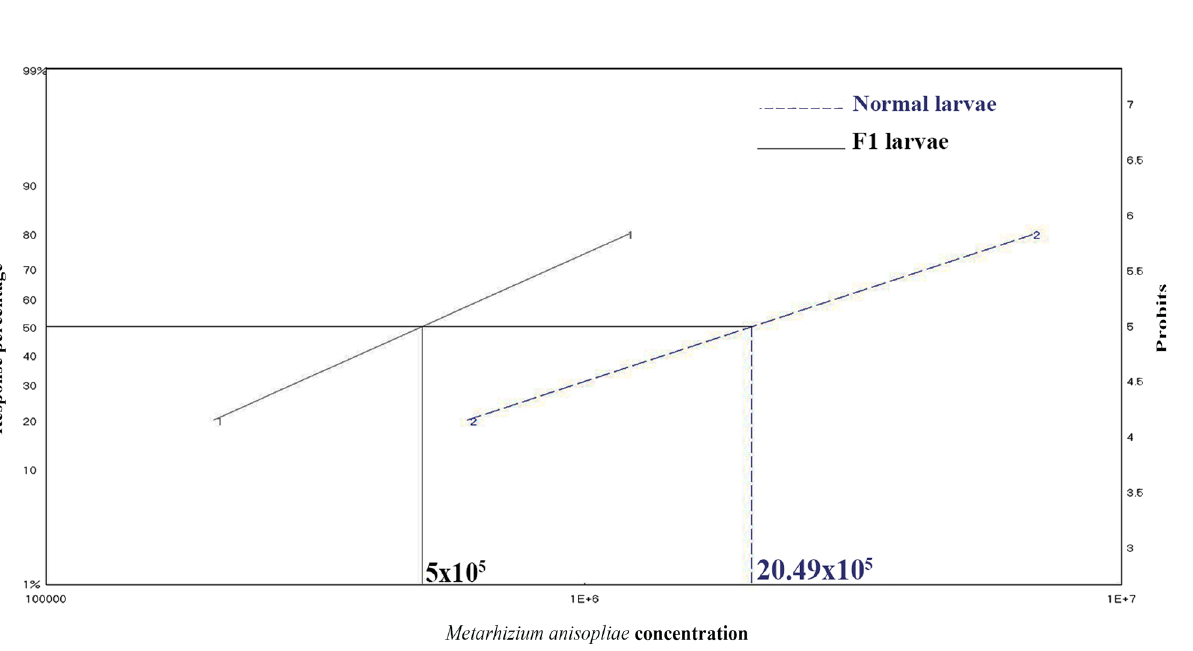
Toxicity Index and resistance ratio compared with accumulative mortality on F1 larvae